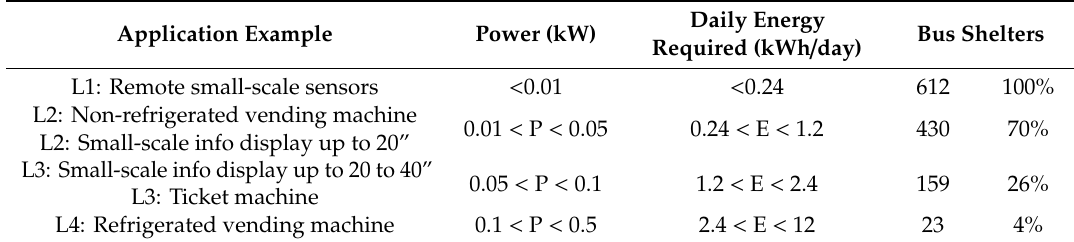
Table 2. Solar bus shelters suitable for PV-typified applications.